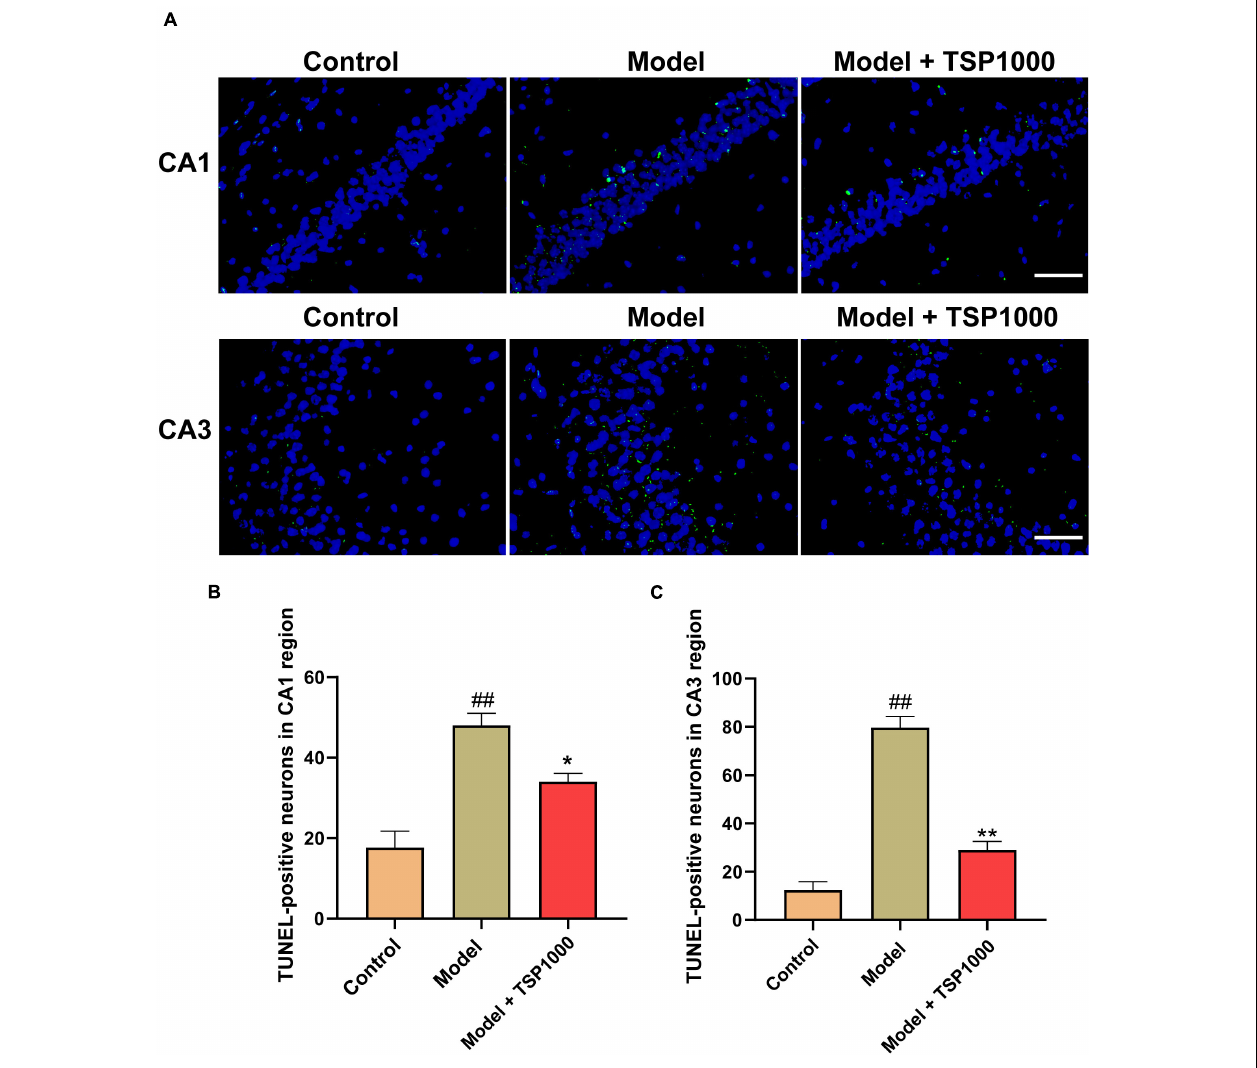
FIGURE 5 | The effects of TSP on neurons apoptosis in the hippocampus. (A) Photomicrograph demonstrates in situ apoptotic neuron detection by TUNEL stain in the hippocampus of CA1 and CA3 regions (Scale bar: 20 µ m). (B) The number of TUNEL-positive neurons was quantified. All data were expressed as mean ± SEM ( n = 3). ## P < 0.01 vs. Control group; * P < 0.05, ** P < 0.01 vs. Model